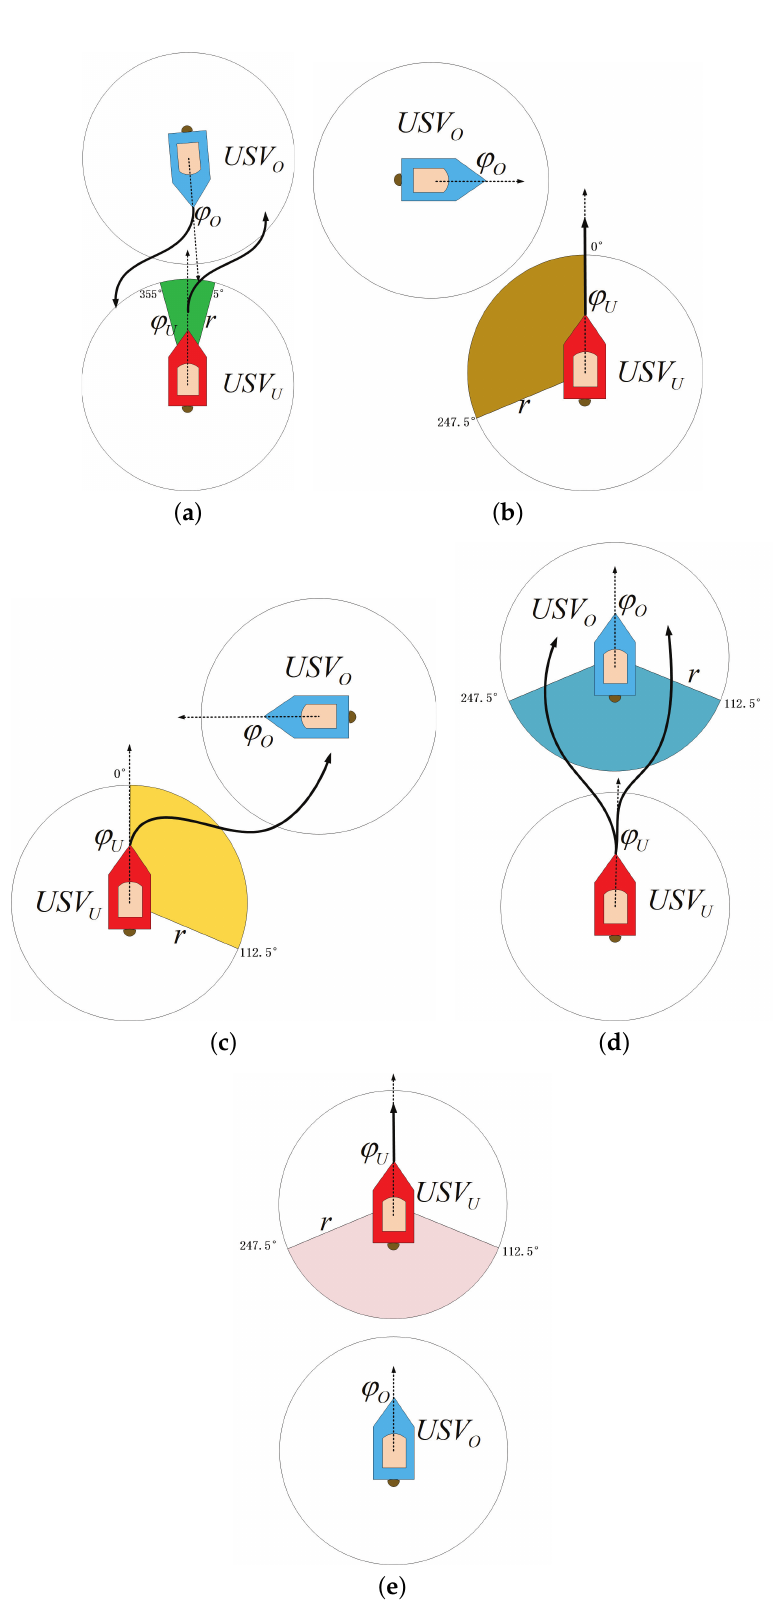
Figure 2. Encounter situation. ( a ) Head-on; ( b ) Crossing-stand-on; ( c ) Crossing-give-way; ( d ) Overtaking-give-way; ( e )